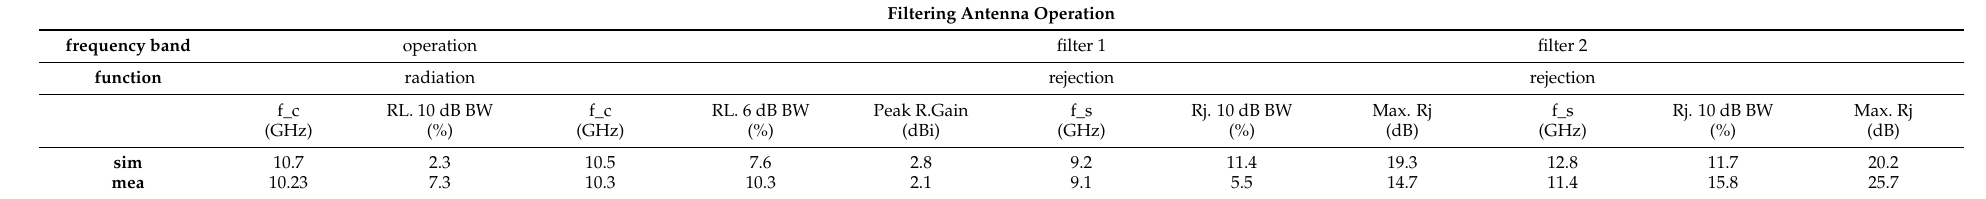
Table 4. Simulated and measured IM-GWG Filtering antenna comparison